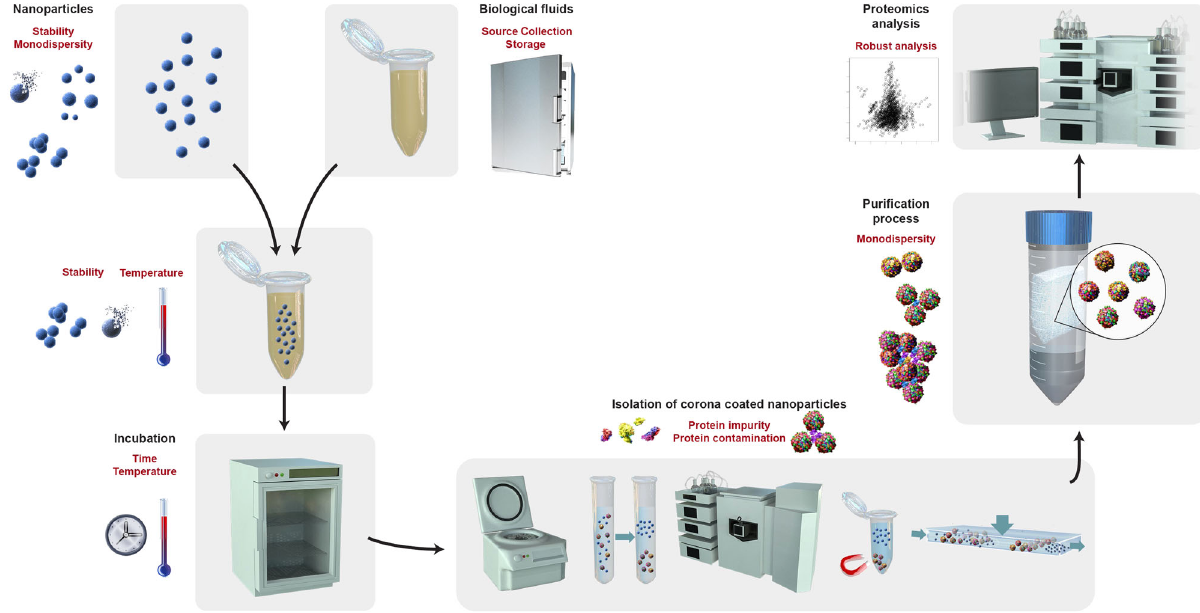
Fig. 1 General process for preparation of protein corona and common sources of errors and misinterpretation. General steps for preparation of protein corona in vitro or ex vivo: preparation of nanoparticles and biological fl uids; mixing of nanoparticle and biological fl uids; incubating the mixture for a certain time and at a speci fi c temperature; isolation of protein corona – coated nanoparticles using the fi ve most common approaches (i.e., centrifugation-based, gradient centrifugation, size exclusion chromatography, magnetic separation, and fi eld- fl ow fractionation); puri fi cation process; and protein corona characterization by proteomic techniques. Red text shows the common methodological features that may cause errors in the outcomes of proteomics analysis of the protein corona (e.g., considering protein impurities in the proteomics